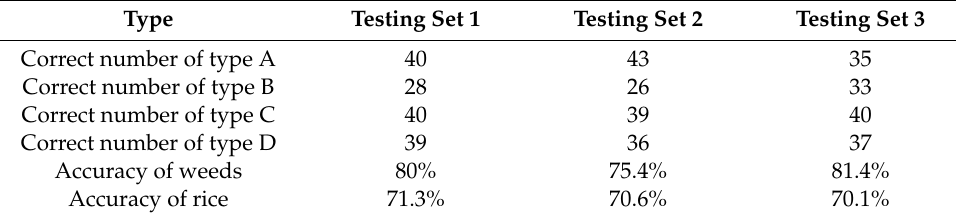
Table 5. Network accuracy results for group I.